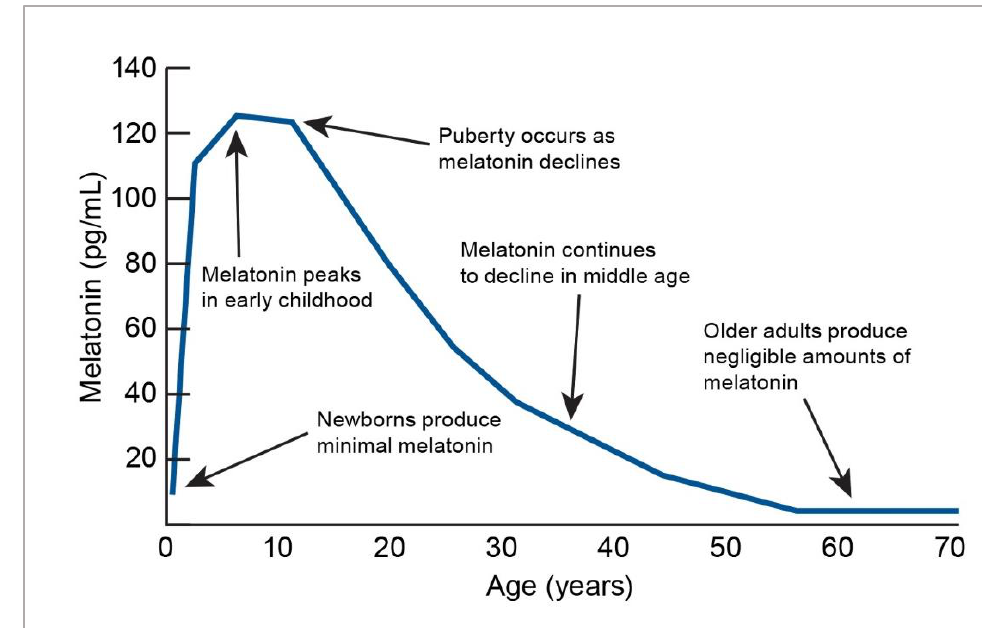
Figure 1. Age-related decrease in melatonin in humans. Modified from [10].